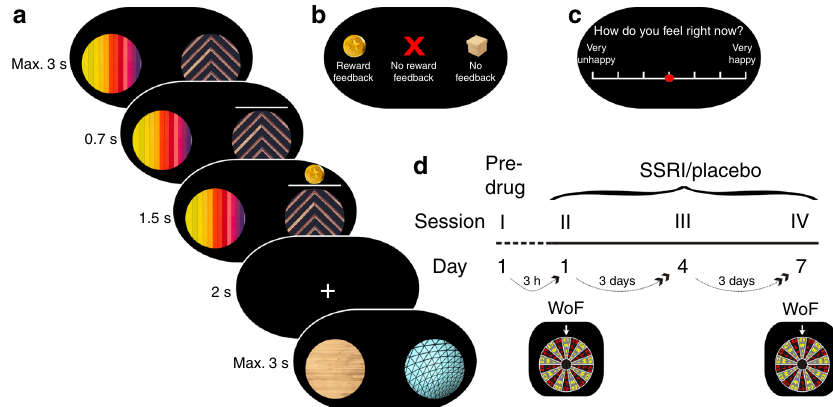
Fig. 1 Experimental task and study design. a Trial structure. On every trial, subjects had 3 s to make a choice between two presented images. The chosen image was highlighted for 0.7 s. Subsequently, an outcome, either reward (gold coin), no reward (red cross), or no feedback (box), was shown above the image for 1.5 s. After a 2 s fi xation cross period, the next trial started. b Different outcome types. On learning trials, subjects encountered either a monetary reward (gold coin, £0.03), or no reward (red cross) outcome, depending on the chosen image ’ s associated reward probability. Here, each image was associated with either a fi xed high (70%) or a fi xed low reward probability (30%). On test and interleaved maintenance trials, outcomes were not revealed. Instead, they were ‘ hidden in a box ’ visible to subjects. Subjects were instructed that images still led to reward outcomes, depending on reward probabilities. However, to prevent new learning at this stage, feedback was not shown. c Mood rating. Multiple times per block (three times during blocks of 48 trials, four times during blocks of 72 trials; fi xed intervals), subjects were asked to report their current emotional state by responding to the question ‘ How do you feel right now? ’ . The rating was provided without time restriction by moving a red cursor that always started at the midpoint along a scale ranging from ‘ very unhappy ’ to ‘ very happy ’ . d Study design. Subjects were randomly allocated to take a daily dose of 20 mg citalopram or placebo for 7 days and participated in four session over the week: a pre-drug session I on day 1, and three sessions on the drug, on days 1, 4, and 7 (sessions II, III and IV). To modulate subject ’ s affective state between learning blocks, a Wheel of Fortune (WoF) draw was held in session II (day 1) and IV (day 7). Cf. Supplementary Fig. 1 for details on session structure and image appearance across the entire